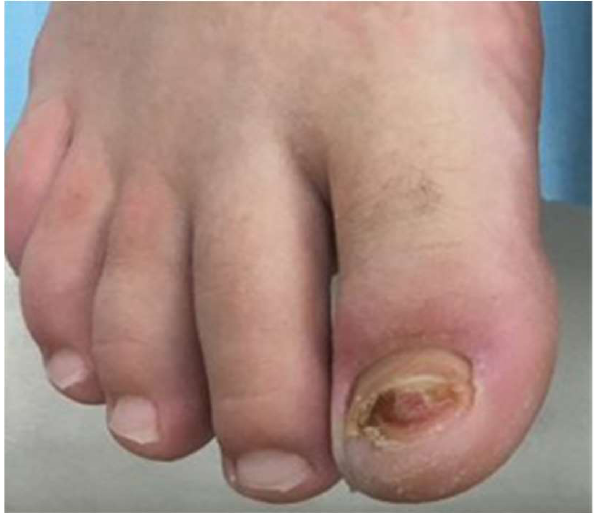
Figure 4. Subungual erythematous nodule covering the majority of the right big toenail bed.